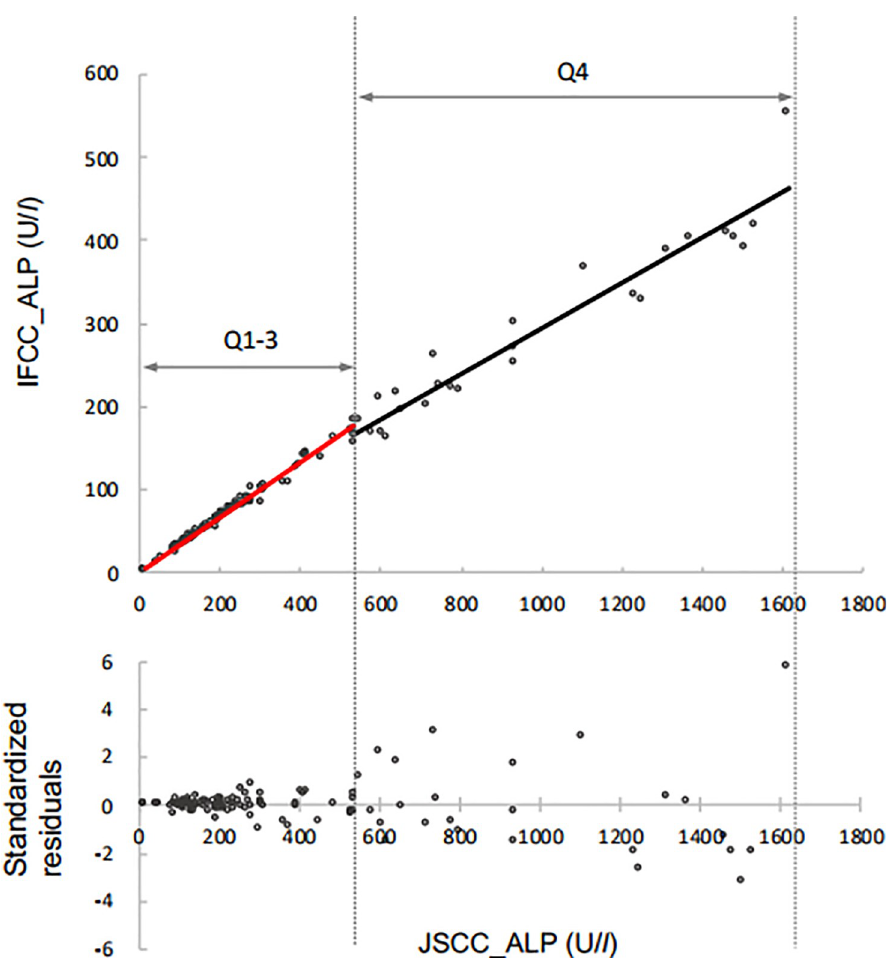
Fig 2. Results of the regression analysis between JSCC and IFCC in Q1–3 and Q4 in 108 canine samples, represented by the following equations: y = 0.331 x − 0.045 and y = 0.286 x + 9.293, respectively. Using these formulas, standardized residuals calculated in Q1–3 and Q4 showed no